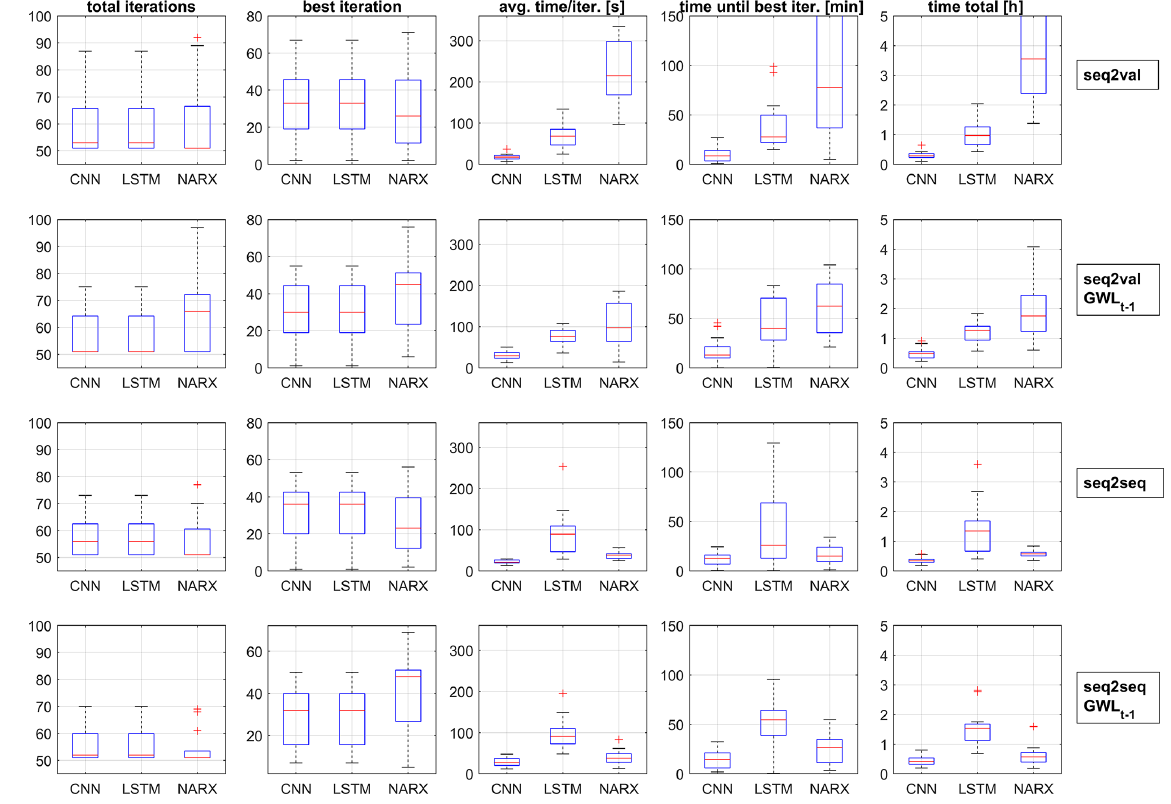
Figure 9. Comparison of the performed HP optimizations (columns 1 and 2); their calculation time per iteration in seconds (column 3), until the optimum was found (minutes) (column 4); and the total time spent on optimization in hours (column 5).